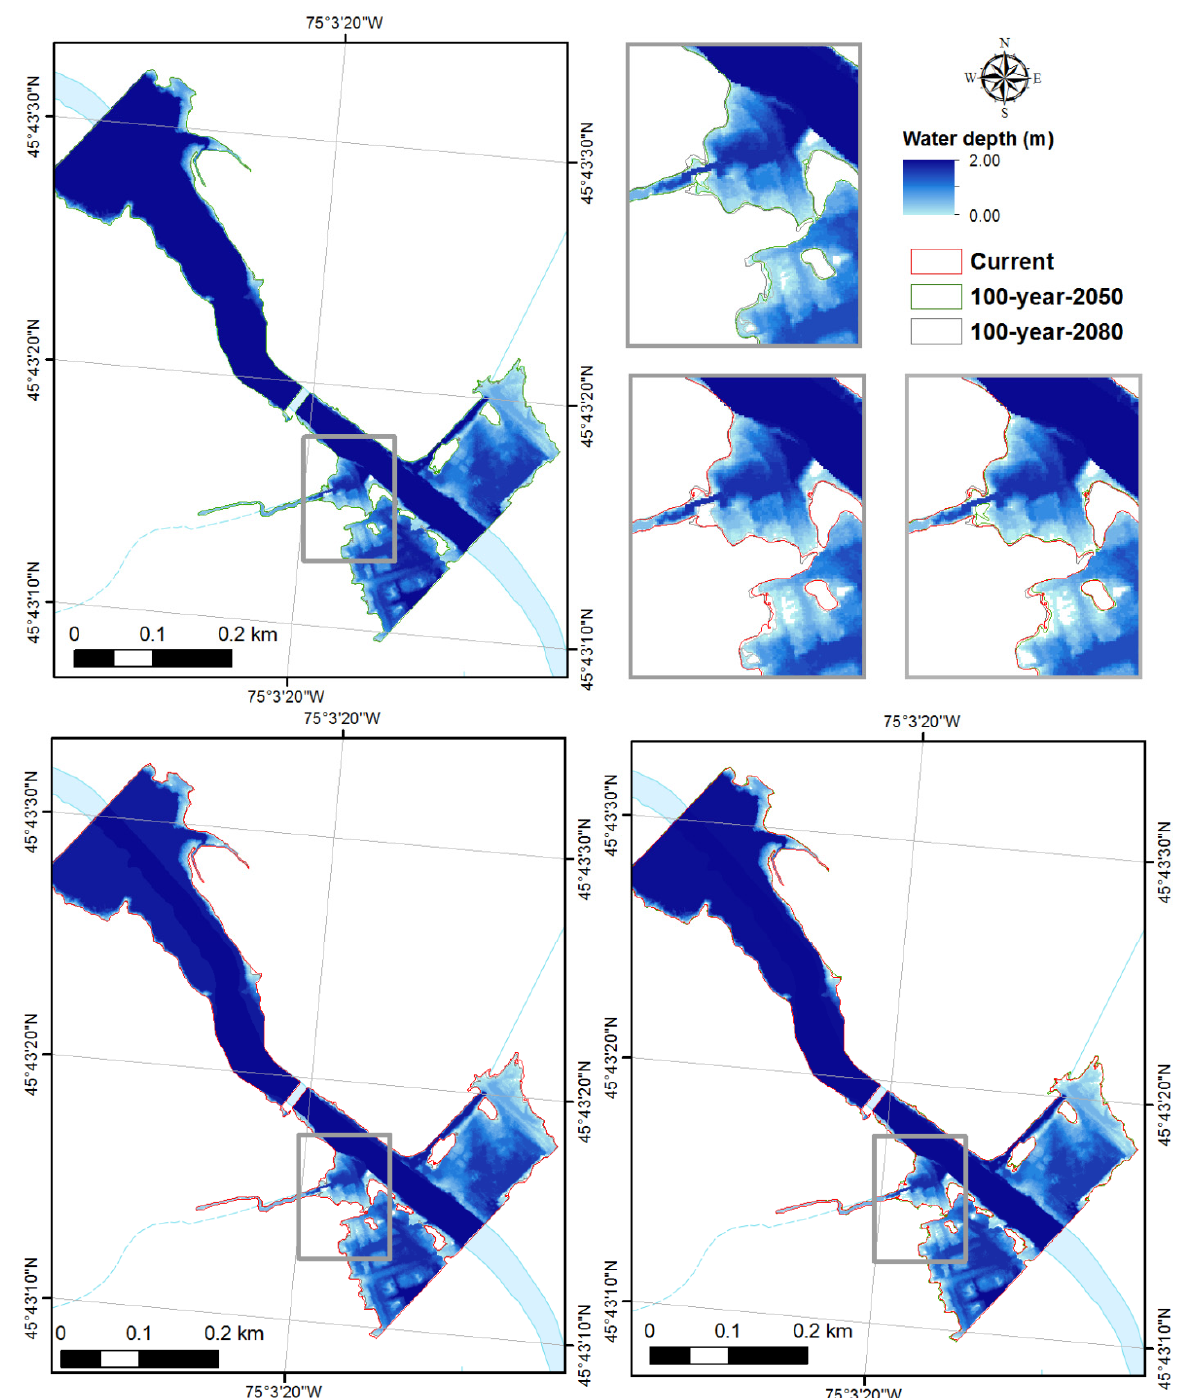
Figure A8. Projected flood depth for a 100-year return period. Case: St-Andre-Avellin.